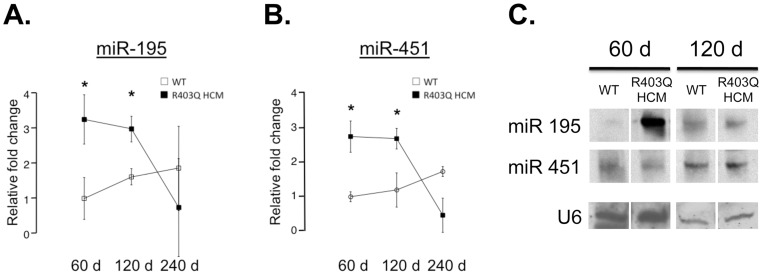
miR-195 and miR-451 expression in WT and R403Q HCM hearts.
A: Expression levels determined by RT-PCR of miR-195; B: miR-451 (right panel) in 60, 120, and 240 day male WT and R403Q HCM hearts corrected by U6 expression (n = 3 for each group, *p<0.05), C: Northern blot analysis of miR-195 and miR-451 expression in WT and R403Q HCM hearts. Northern blot analysis using LNA-modified, 5′ end biotin-conjugated prob1es for U6 RNA, miR-195 and miR-451 using RNA extracted from 60-day- and 120-day-old WT and R403Q HCM hearts. Each lane represents one sample of extracted RNA pooled together from 4 total hearts. Northern blot images in C are taken from the same blot but were cropped for clarity.